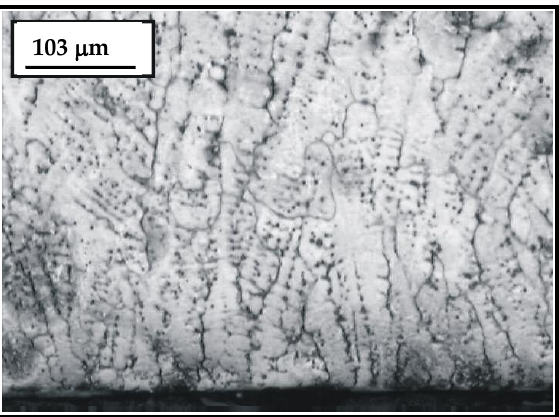
Figure 9. Elongated dendritic structure of the hard-faced layer executed by the GTAW welding procedure and filler metal DUR 600-IG. The sample hard-faced with the FM UTP 670 has the medium to large-grained struc- ture, with individual dendrites width of 30 to 80 μ m. The large share of excreted carbides along the grain boundaries is noticed in the structure (light areas in Figure 10), however the largest portion is within the metal grains.